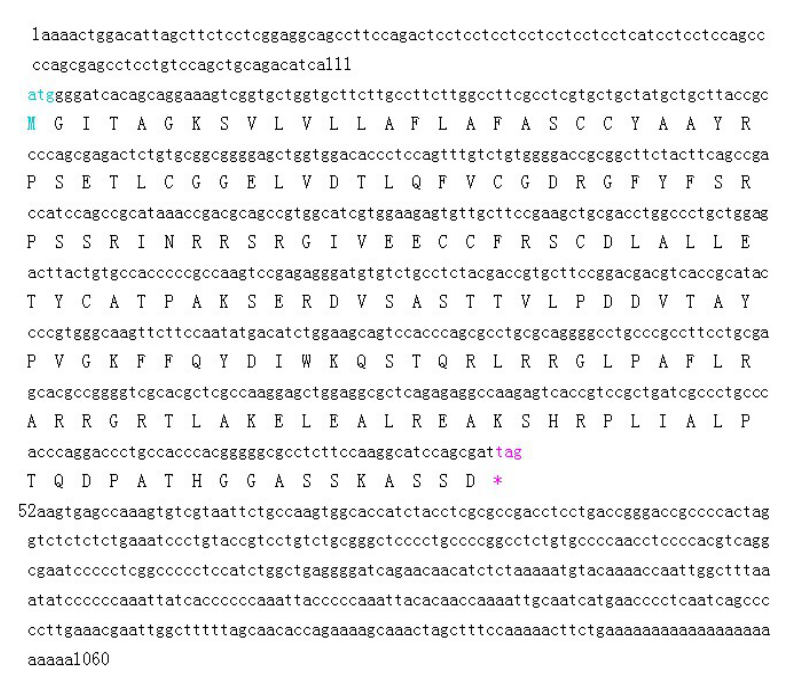
Figure 2. Complete nucleotide sequence encoding Bos grunniens IGF2 and deduced amino acids of the cloned IGF2. The sequences were submitted to NCBI GenBank (accession number KF682139). * was the termination codon.